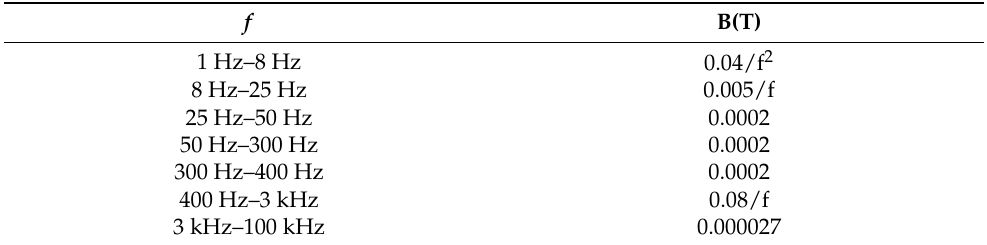
Table 1. Reference level of magnetic field exposure in the operating frequency range of 1 Hz–100 kHz in ICNIRP-2010.